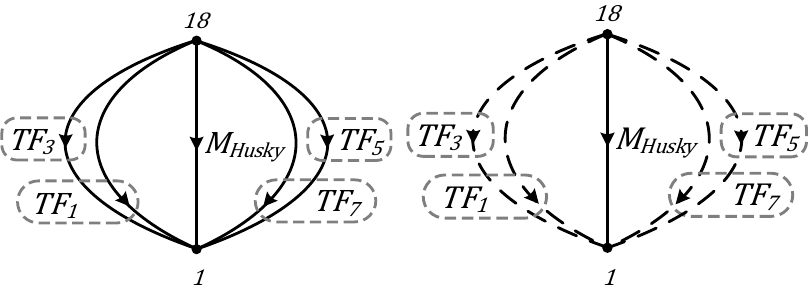
Figure 8. LG model and the normal tree of the Husky robot translational dynamic subsystem.